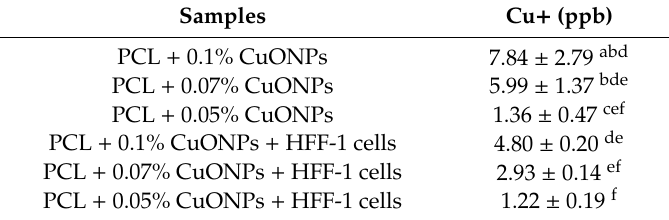
Table 2. HRCS GFAAS analysis of extracts of active PCL films with di ff erent concentrations of CuONPs.